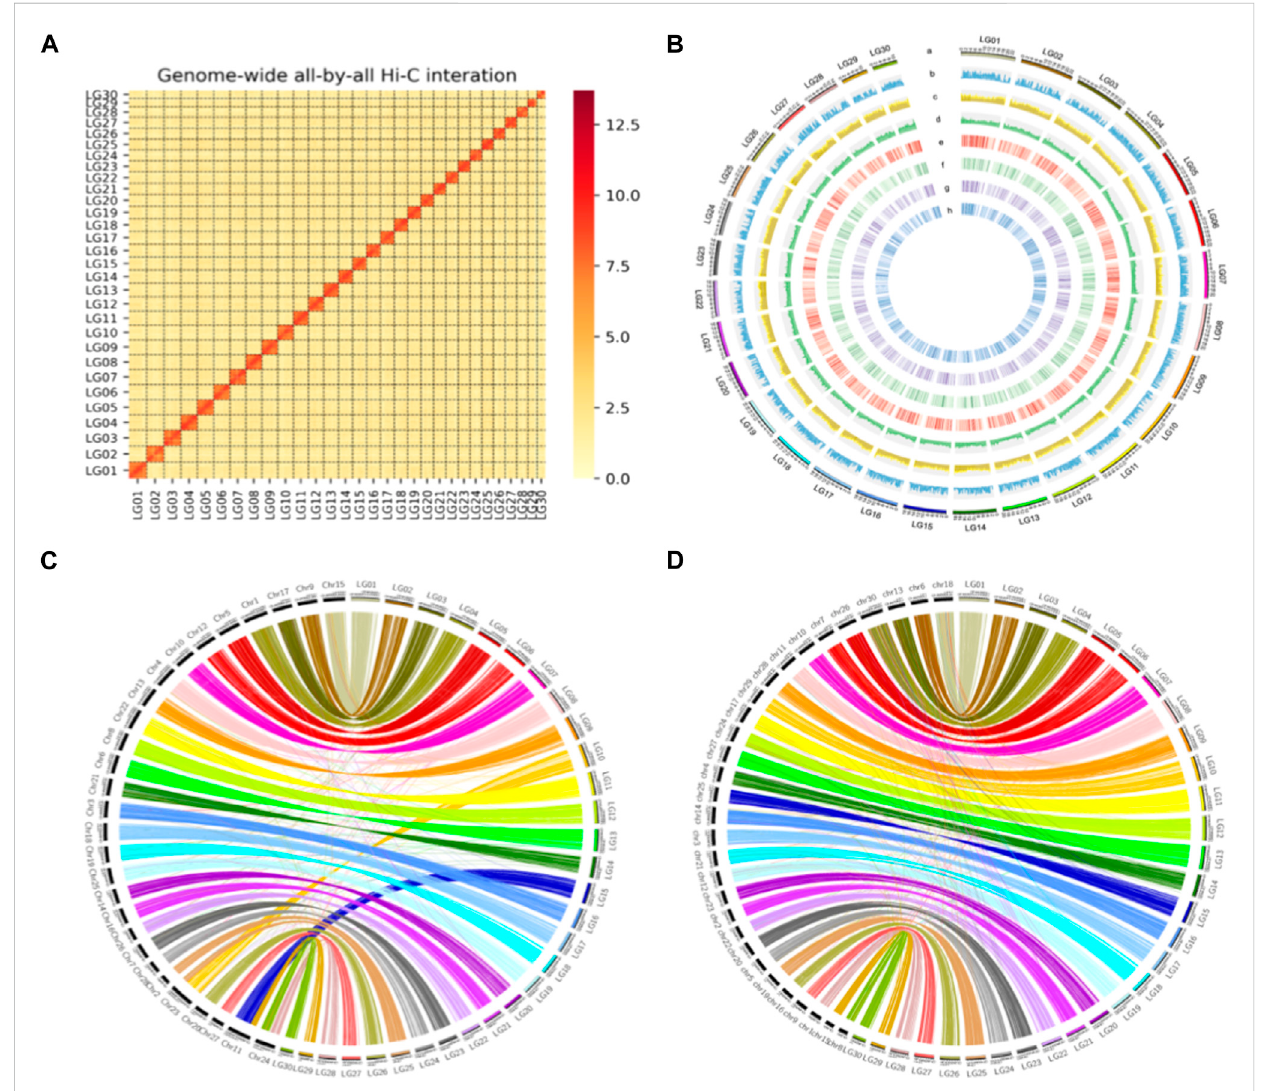
FIGURE 2 High quality denovo assembly of S.montelus . (A) Interaction heatmap betweenanytworegions ofthewholegenomeintra-and interchromosome with Hi-C data. (B) Whole-genome feature distribution of S. montelus with 1-Mb-wide bins. a , Chromosome (30 chromosomes); b , gene density (13,720 protein-coding genes); c , repeat density (repeat content 48.9%); d , GC content distribution (average GC content 35.9%); e , egg stage gene expression (75%ofgeneshave expression); f ,larvastagegeneexpression(84%expression); g ,pupastagegeneexpression(77%expression); h ,adult stage gene expression (86% expression). (C) Protein-coding gene synteny between S. montelus (right) and Bombyx mori (left). (D) Protein-coding gene synteny between S. montelus (right) and P. binaor